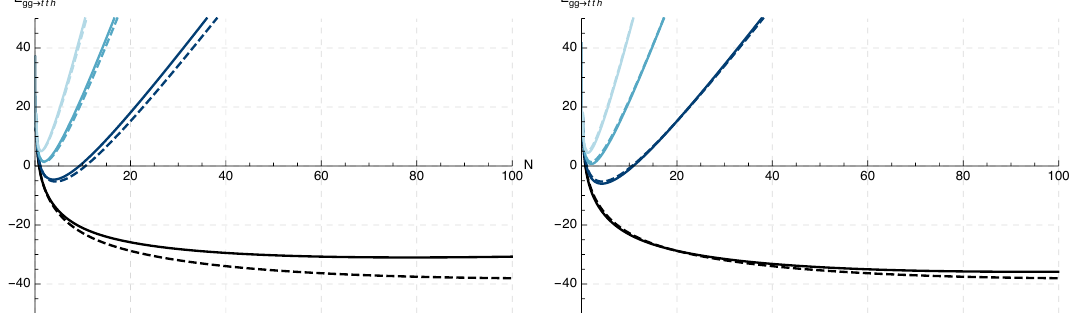
with (solid) and without (dashed) the g ( n ) contributions with n = 1 , 2 for the Figure 9 . E ij → t ¯ th gg -initiated channel. On the left-hand side, we set ln( M 2 /µ 2 ) = 0 , while on the right-hand side we use ln( M 2 /µ 2 ) = 3 . 1 . We show τ/ρ = 0 . 9 (black), 0 . 1 (dark blue), 0 . 01 (blue), 0 . 001 (lightest blue).